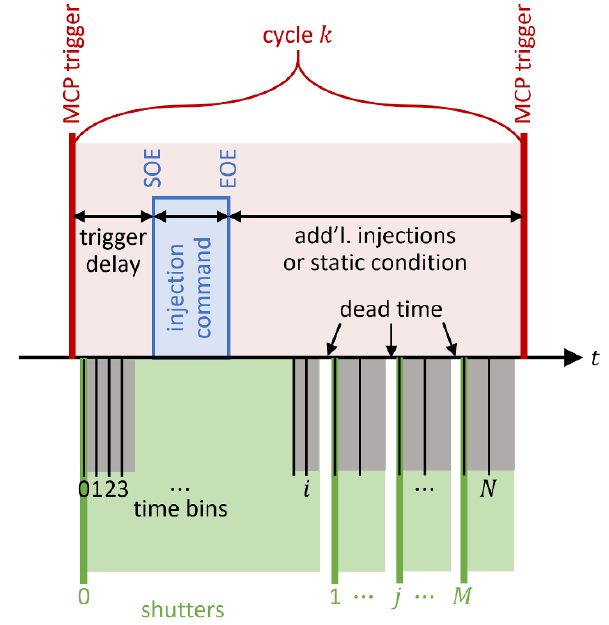
Figure A1. Timing diagram of injection and detector triggering. Table A2. MCP detector shutter timing.